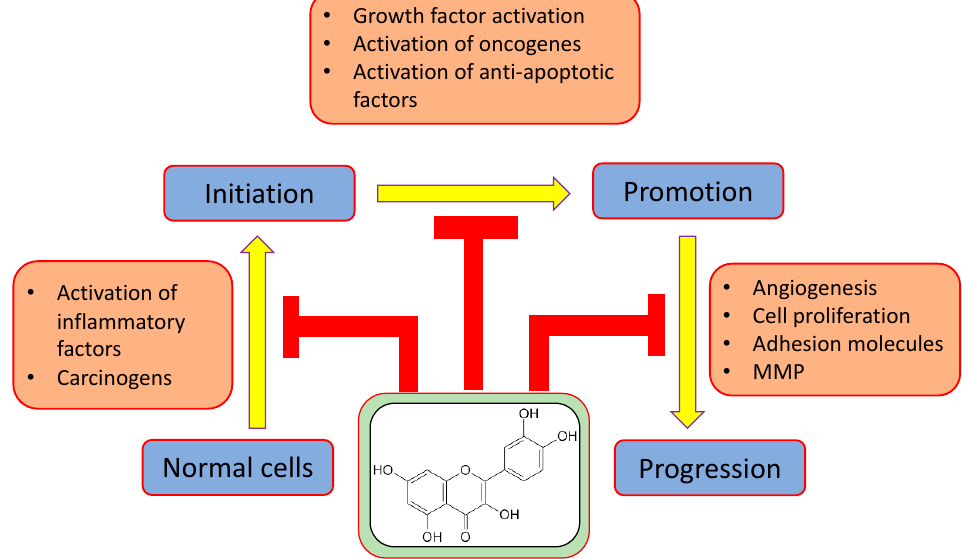
Figure 3. Quercetin has a proven anticancer role in multiple cancers, based on in vivo and in vitro studies.